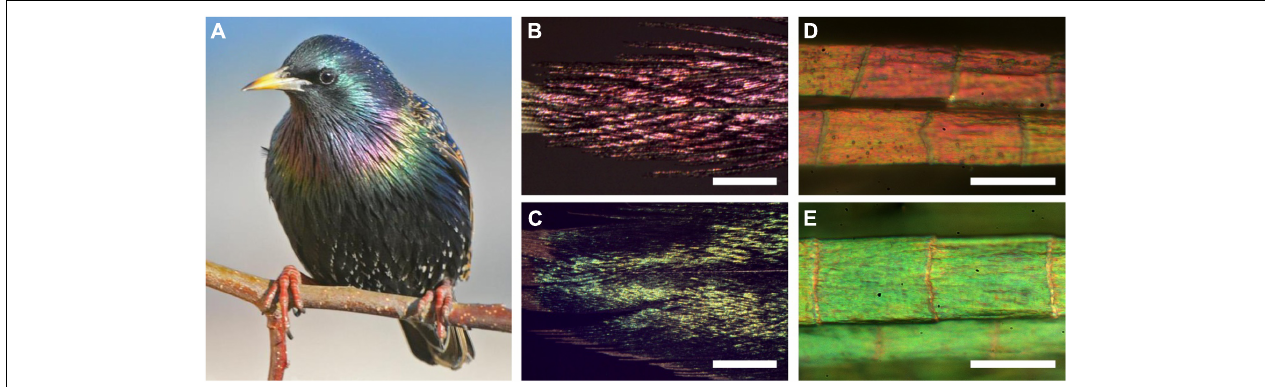
FIGURE 1 | The European starling, Sturnus vulgaris , and its structural colors. (A) A starling with colorful throat and breast feathers (photograph by Nathan deBoer). (B-E) Epi-illumination light microscopy images of (B) a throat feather, (C) a breast feather, (D) throat barbules, and (E) breast barbules. Scale bars: (B,C) 1 mm; (D,E) 50 µ